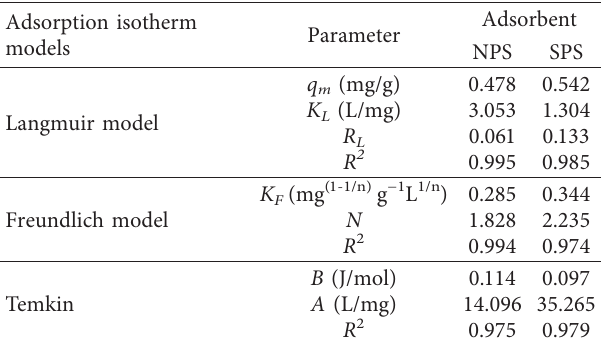
Figure 9: (a) Langmuir, (b) Freundlich, and (c) Temkin isotherm plots for the FD removal by NPS and SPS (1 g adsorbent dosage; 10mg/L concentration of FD; 50ml solution volume; 3 h contact time; and 25 ° C temperature). Table 2: Adsorption isotherm parameters for the FD removal by NPS and